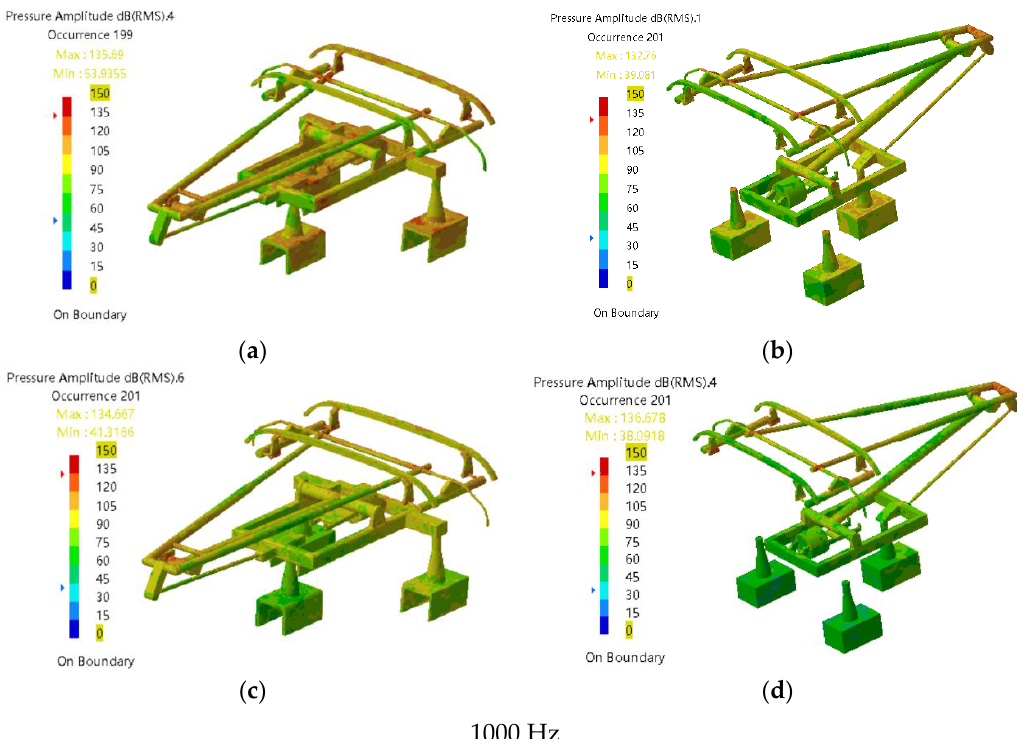
Figure 15. Normalized aerodynamic pressure fluctuation amplitude at 200 and 1000 Hz on: ( a ) down-pantograph with flush base; ( b ) up-pantograph with flush base; ( c ) down-pantograph with sunken base; and ( d ) up-pantograph with sunken base.